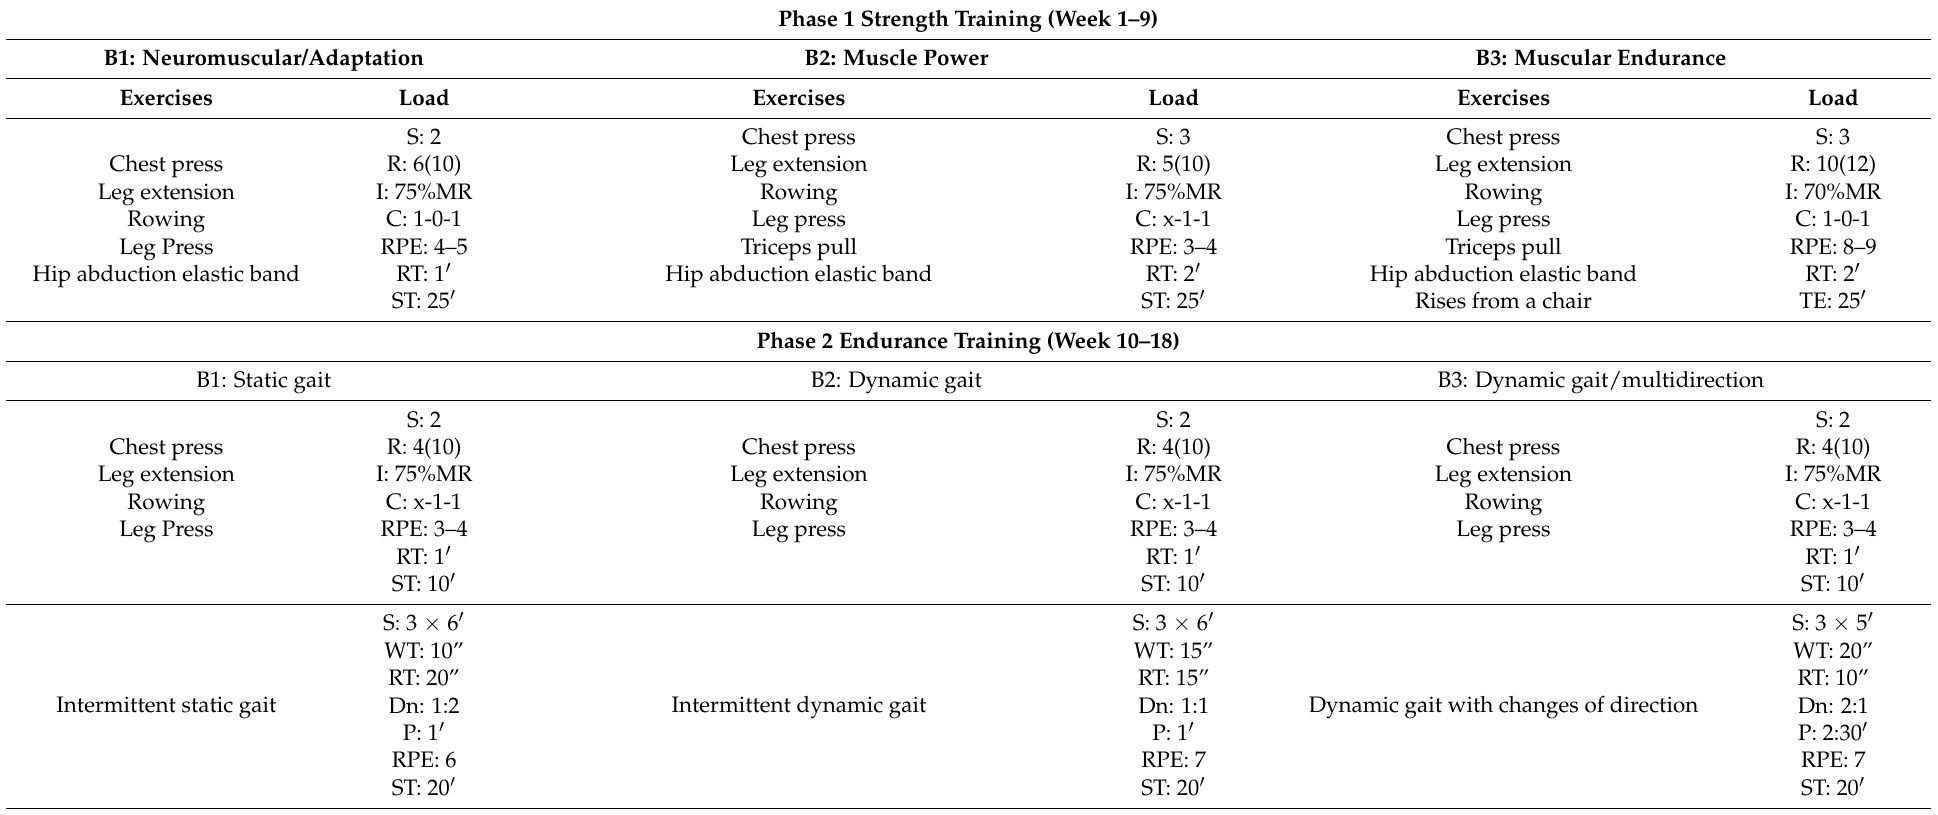
Table 2. Training program by phases or